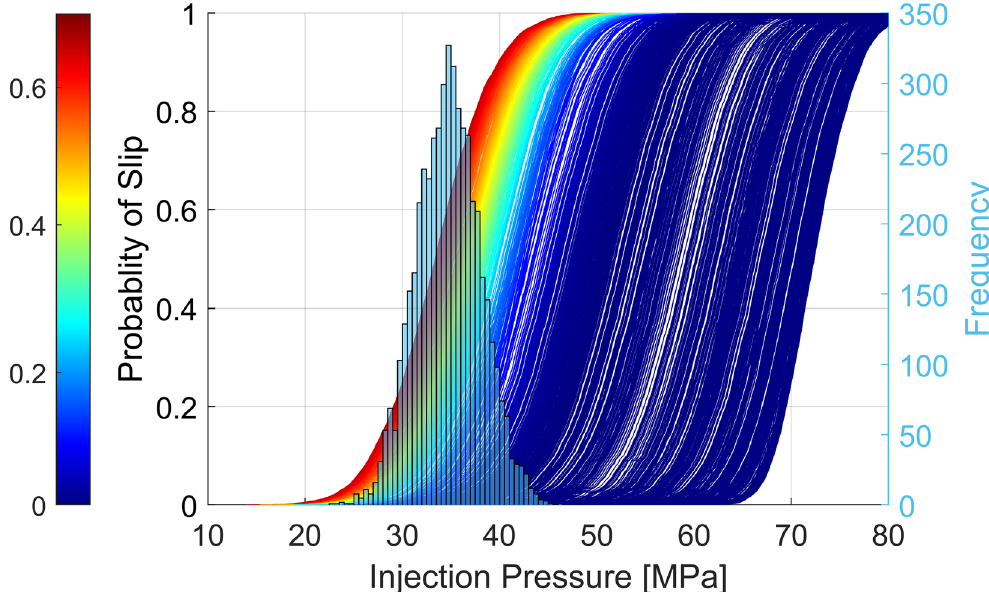
Figure 4. The cumulative probability function of the required injection pressure to cause slip on faults located in stress area 4. The histogram presents the pore pressure distribution in the stress area 4. Each curve represents the cumulative probability function of slip on each fault segment. The difference between current injection pressure and mean Pp distribution is 2 MPa. The depth of injection is assumed to be 2.5 km. This figure was produced using